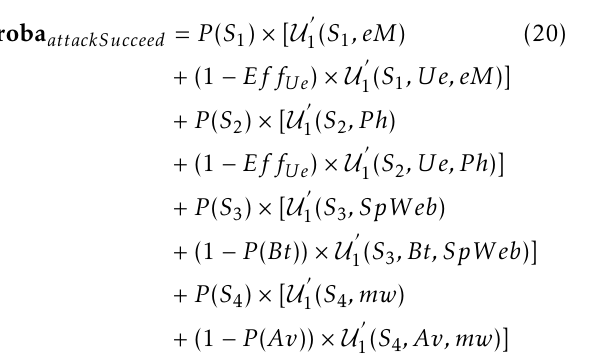
Table 4 records processing values from Equation